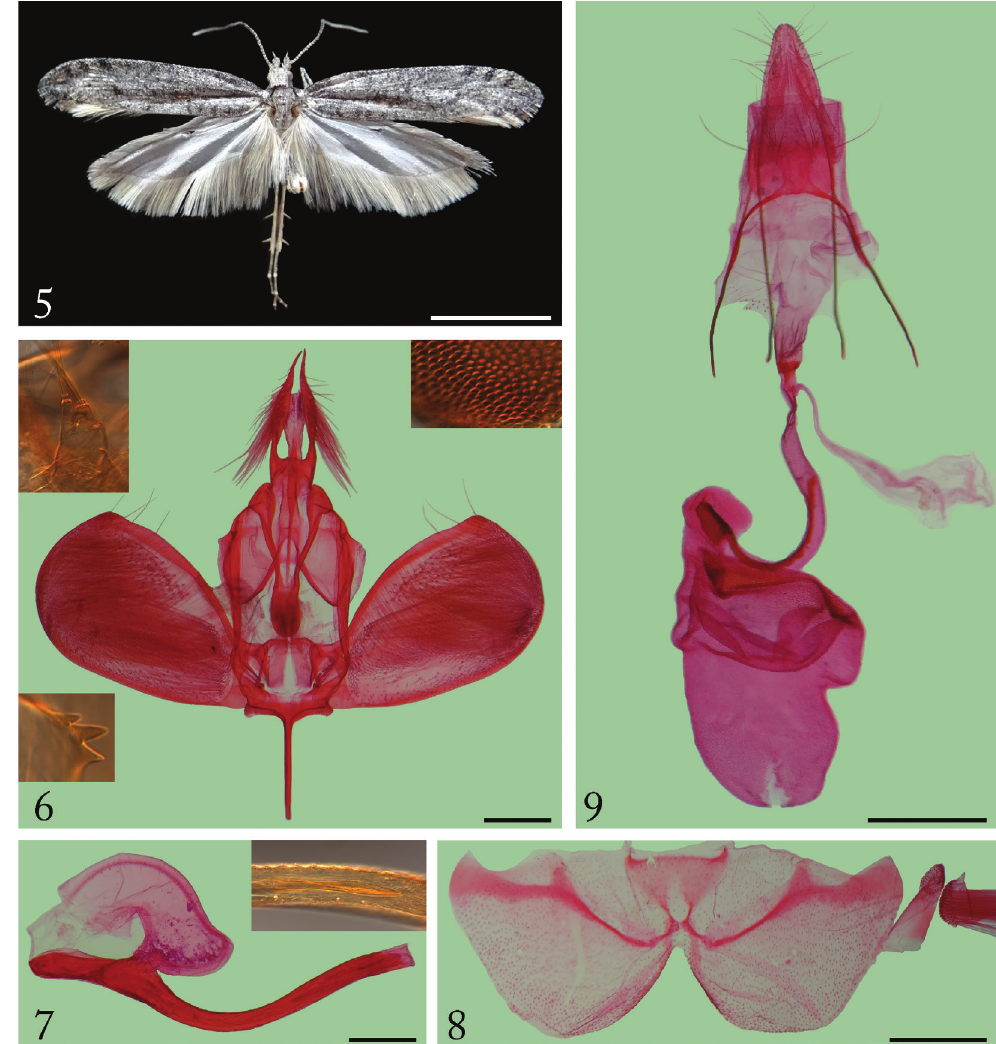
Figures 5–9. Adult stage of Ypsolopha moltenii . 5. Male in dorsal view, holotype. 6. Male genitalia in ventral view; upper left rectangle: detail of the inner face of the base of the left valva close to the costal margin show - ing a cylindrical projection with hair-shaped scales at apex; upper right rectangle: detail of the coarse surface of the ventral arm of the gnathos; bottom left rectangle: detail of the inner face of the base of the left valva close to the ventral margin showing a saw-shaped projection with three teeth. 7. Aedeagus in lateral view; upper right rectangle: detail of the subapical part of the aedeagus showing waved dorsal surface and cornutus. 8. Male abdominal segment VIII, coremata close to right margin. 9. Female genitalia in ventral view. Scale bars 5, 0.25, 0.25, 0.5, 0.5 mm, respectively. Male genitalia (Fig. 6). Tegumen with anterior margin deeply excavated at middle. Socius dig - itate, pointed apex, hair-like scales on the medial third. Gnathos Y-shaped; ventral arm widened, coarse, round apex, length about half the dorsal arms. Saccus narrow, similar length to